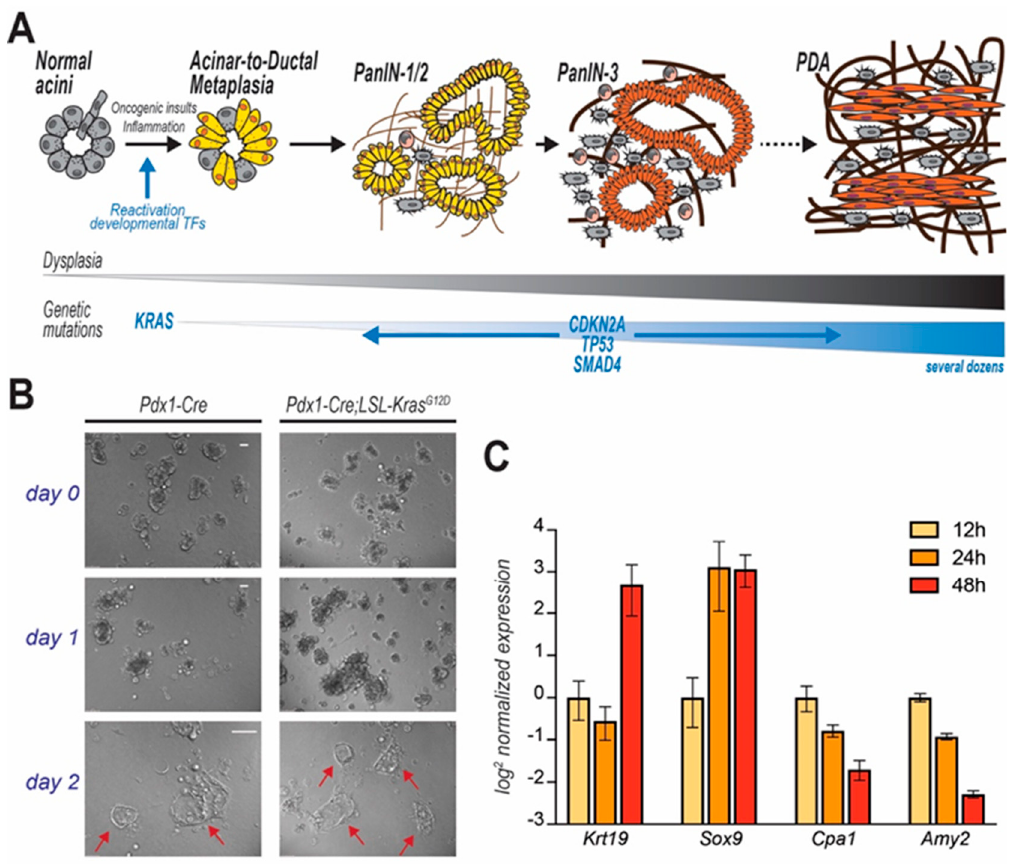
Figure 2. PDA progression and in vitro modelling of disease initiation. In ( A ) step-wise model of PDA progression. Upon mutation of KRAS, pancreatic acinar cells undergo acinar-to-ductal metaplasia (ADM), a cell transforming event which initiates the carcinogenic cascade. Cells progressively acquire dysplastic features and accrue genetic mutations. Acinar cell-derived pre-cancerous lesions are termed Pancreatic Intraepithelial Neoplasms (PanIN) that are defined by di ff erent histological grades and eventually evolve to carcinomas. In ( B ) acinar cells isolated from mice (genotypes indicated), immediately embedded in Matrigel and observed over time. Duct-like cystic structures (arrows) are observed after few days. In ( C ) time course analysis reveals that KC-derived primary acinar cells undergoing ADM ex vivo (Matrigel-embedded) upregulate duct-specific genes ( Krt19 and Sox9 ), and suppress acinar-specific genes ( Cpa1 and Amy2 ). Data for each gene are normalized to the first time point (12 h post isolation).